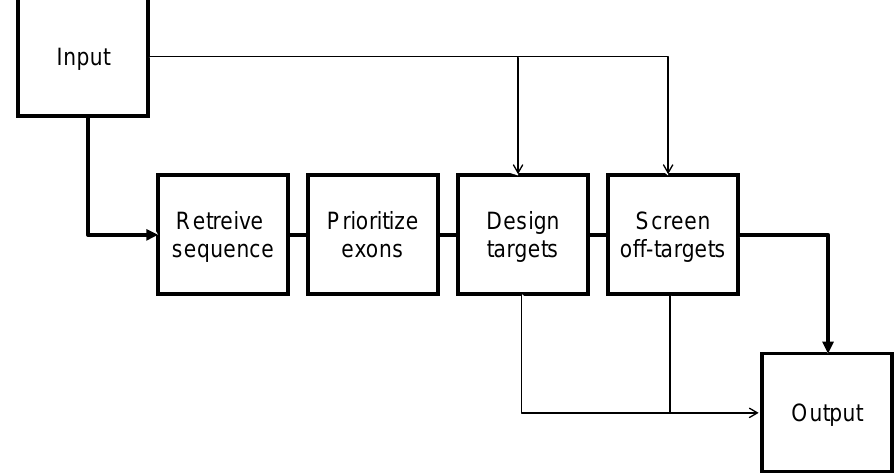
Figure 1: The workflow of COD system. The COD system provided an automatic pipeline of mutagenesis using sequence-specific endonucleases, e.g. Cas9. Given an Entrez gene ID, gene knockouts can be processed through the workflow indicated by the thick arrows. Also, any user defined DNA sequence can be processed to design Cas9 targets and analyze off-targets as indicated by the thin